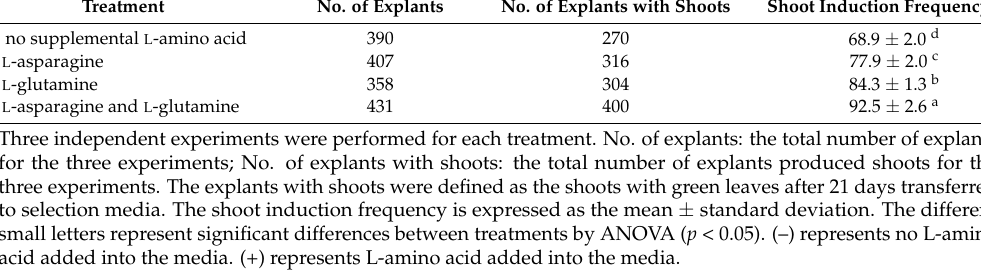
Table 1. Shoot induction frequenciesofthe different treatments. Treatment No. of Explants No. of Explants with Shoots